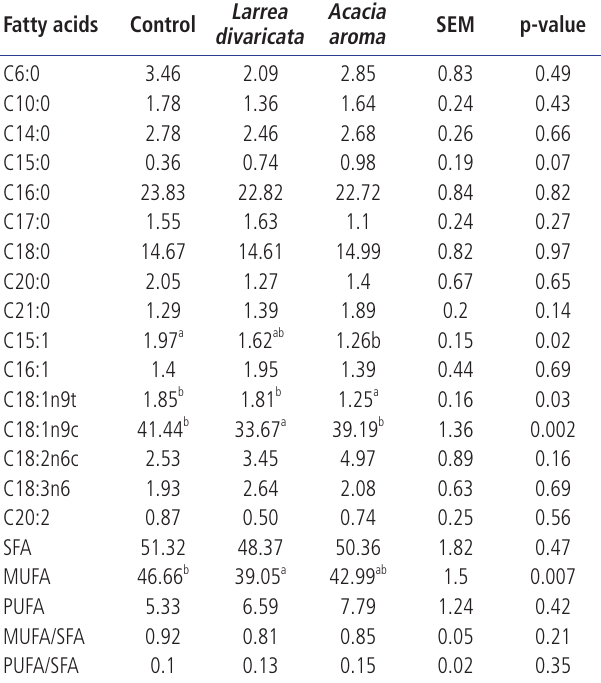
Table 4. Fatty acid composition in meat intramuscular fat of goats (n = 6) fed Larrea divaricata and Acacia aroma supplemented diets Larrea Acacia Fatty acids Control divaricata